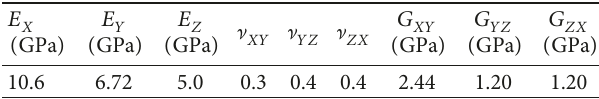
Table 6: Geometry and material parameters of the aluminum plate layer at reference temperature (25 ° C).